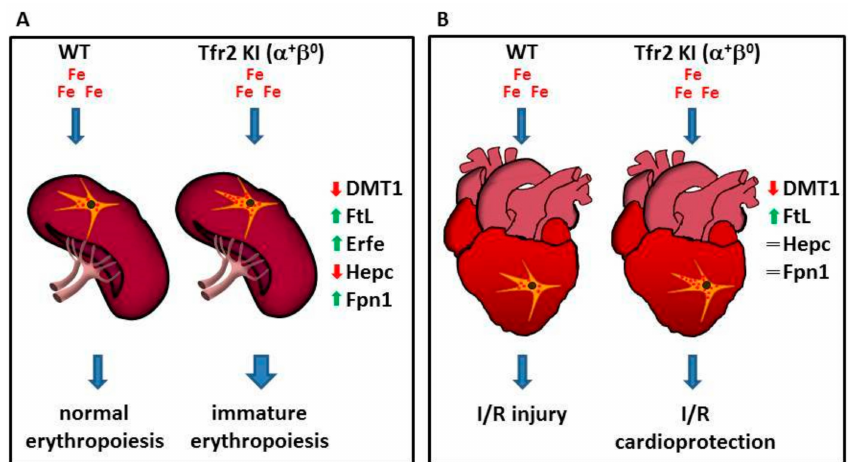
Figure 3. Schematic model illustrating Tfr2 β function in regulation iron export from reticulo-endothelial (REL) cells. Lack of Tfr2 β causes an increased iron retention in REL cells that ( A ) causes the onset of an immature erythropoiesis in the spleen, and ( B ) induces a cardioprotection against the effect of the reperfusion of oxygenated solutions after an ischemic event in heart (see